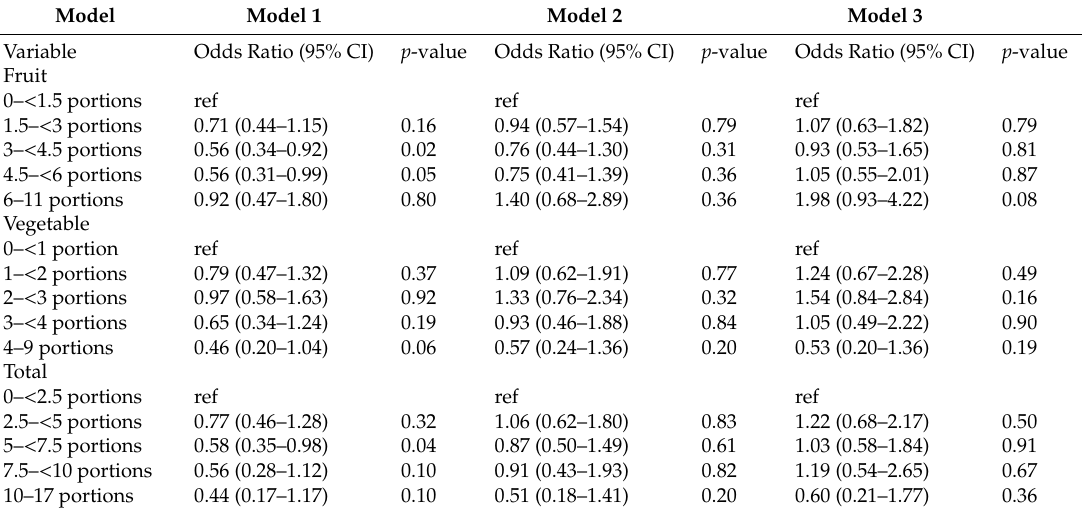
Table 2. Associations between daily fruit and vegetable consumption and incident frailty risk over 4 years among 2634 non-frail community-dwelling older people in